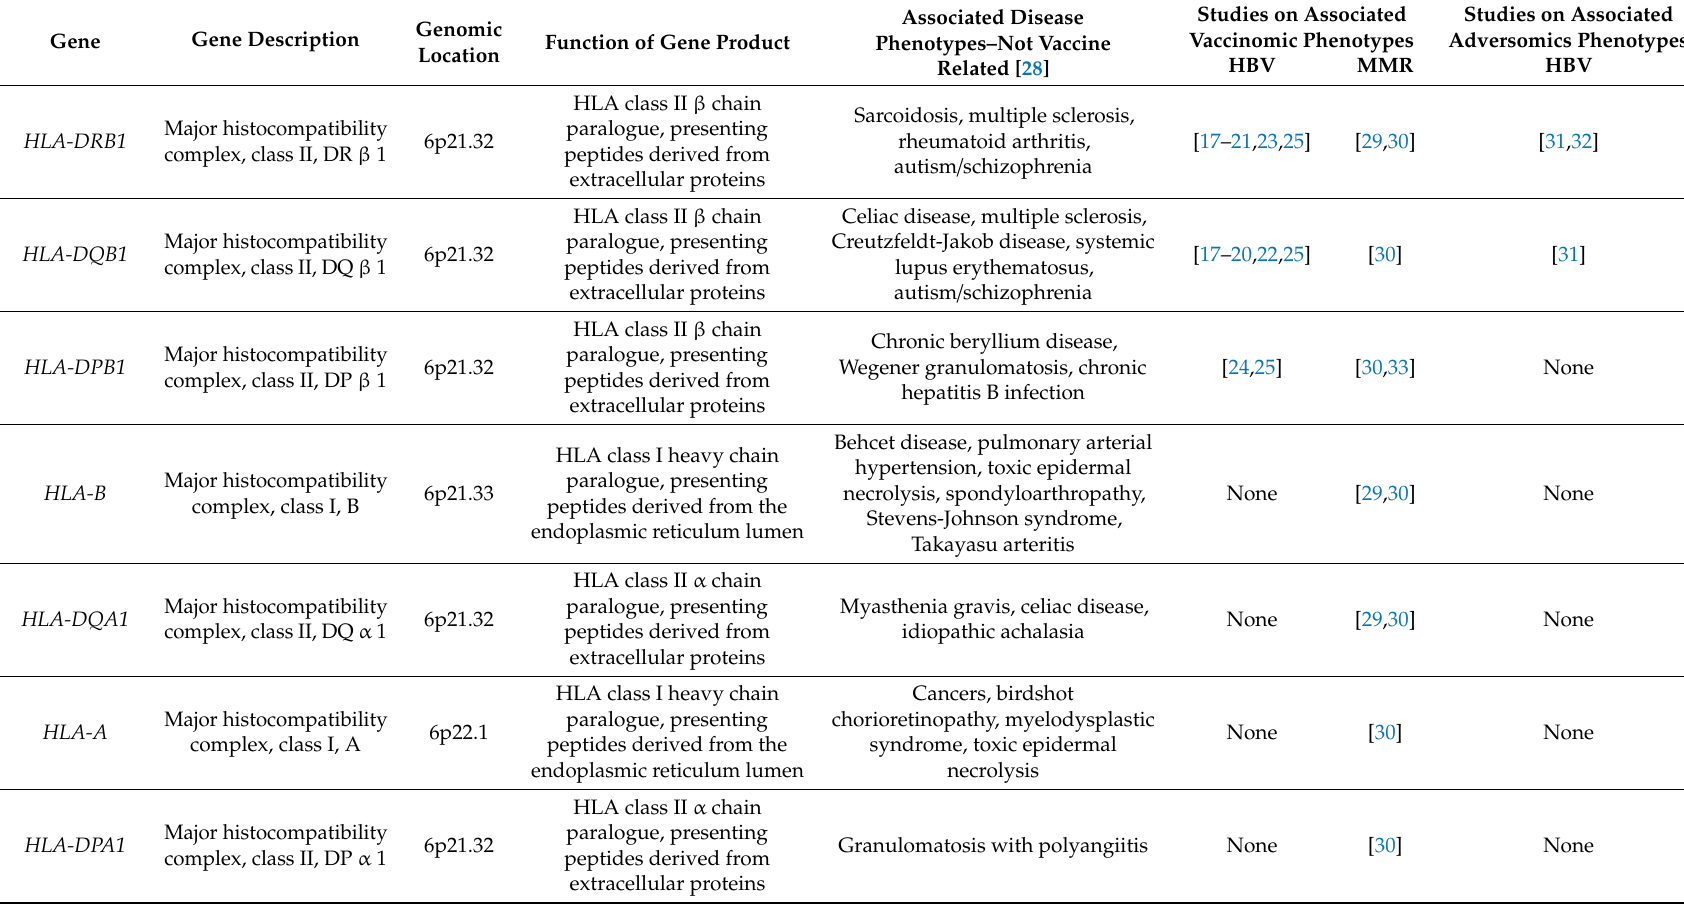
Table 1. Details of HLA genes associated with HBV and MMR vaccine e ffi cacies and safety. HLA: human leukocyte antigen; HBV: Hepatitis B virus; MMR: measles, mumps, and